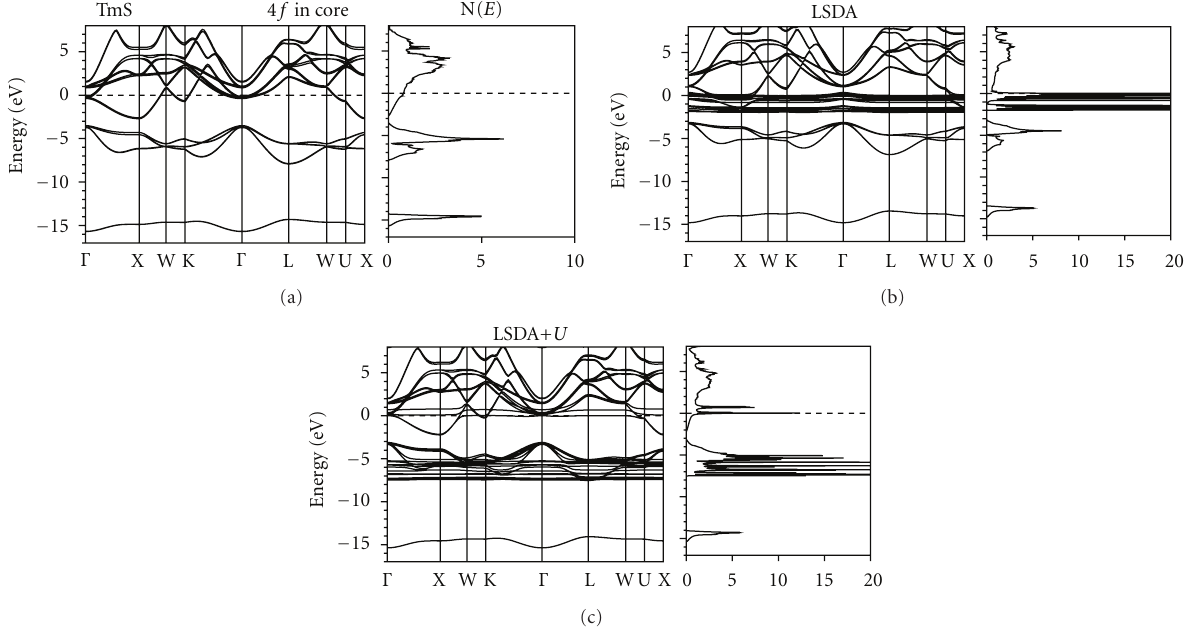
Figure 61: Self-consistent fully relativistic, spin-polarized energy band structure and total DOS (in states/(unit cell eV)) calculated for TmS [384] treating the 4 f states as (a) fully localized (4 f in core), (b) itinerant (LSDA), and (c) partly localized (LSDA+ U